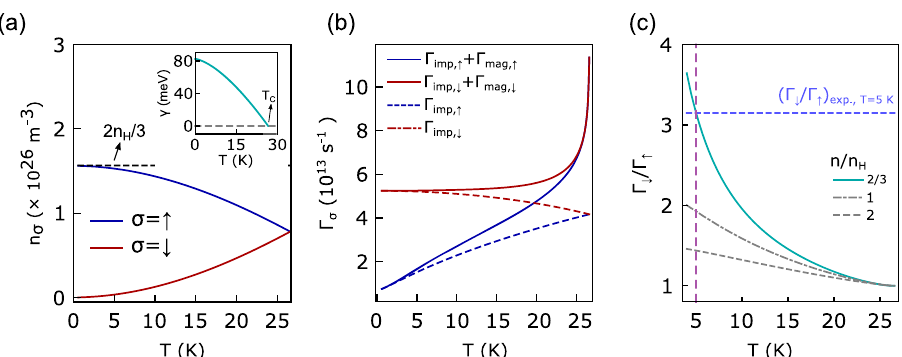
Fig. 4 Theoretical model results. a Spin resolved carrier (hole) density n σ as a function of temperature T below the magnetic transition T C ≈ 26 K in the theoretical model with n = n ↑ + n ↓ . We choose n = 2 n H /3, where n H = 2.35 × 10 26 m − 3 is extracted from Hall measurements, JS ħ 2 = 165 meV, and J S ħ 2 = 0.15 meV. Inset shows Zeeman energy shift γ ( T ) proportional to magnetization in FM phase. b Total minority and majority scattering rates Γ ↓ FM and Γ ↑ (solid) as a function of T , where Γ σ = Γ imp, σ + Γ mag, σ . Dashed lines show impurity scattering contributions, which dominate at low T . Upturn close to T C is caused by scattering with magnons that proliferate at the phase transition. c Ratio of minority over majority quasiparticle scattering rates, function of T for different carrier densities n / n H . The ratio increases for decreasing T and n , and is larger than unity. The blue dashed line marks the experimental value of Γ ↓ / Γ ↑ at T = 5 K extracted from